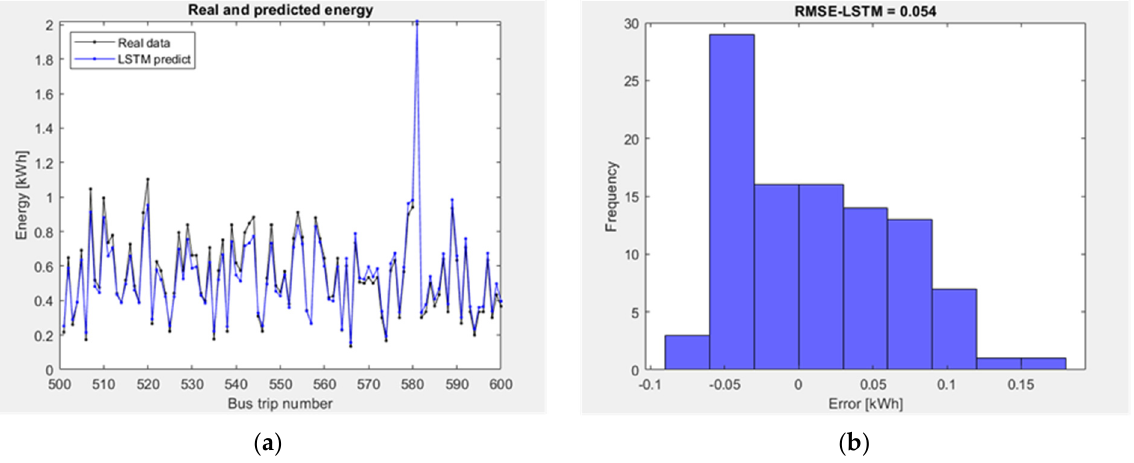
Figure 10. ( a ) Real and predicted energy consumption for test data from 501 to 600; ( b ) histogram for RMSE errors for DLNA networks for 100 test data.